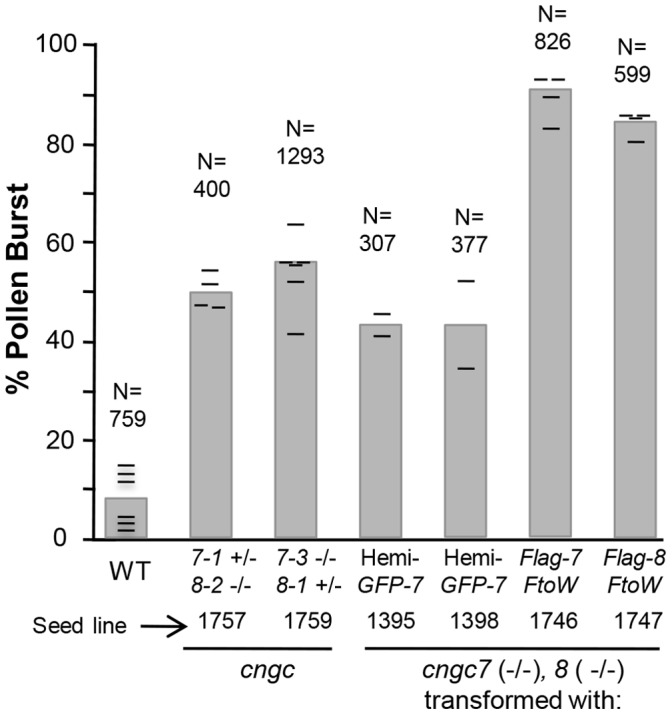
Mutant cngc7/8 pollen grains burst during in vitro germination.Pollen grains were germinated in vitro and scored for bursting at the time of germination. A ∼5-fold higher bursting frequency was observed for two different combinations of cngc7/8 alleles (cngc7-1+/−, 8-2−/− and cngc7-3−/−, 8-1+/−) in which only one of the alleles was segregating. An equivalent bursting frequency was observed for a cngc7-3/8-1 double knockout in which only 50% of the pollen harbored a rescue construct encoding GFP-CNGC7 (GFP-7) (denoted by “Hemi-”). A ∼90% bursting frequency was observed when a cngc7/8 double knockout was rescued with a FLAG-CNGC7 or 8 harboring an F to W substitution. In these “F to W” examples, the pollen came from a mixed pool of parental plants that were either hemizygous or homozygous for the transgene (i.e., at least 50% of the pollen had a “rescue” construct). Each hash mark indicates the % bursting for each of the six independent experiments. Results using two different media (standard, and 10% PEG media) showed equivalent results (n = 3 experiments each).